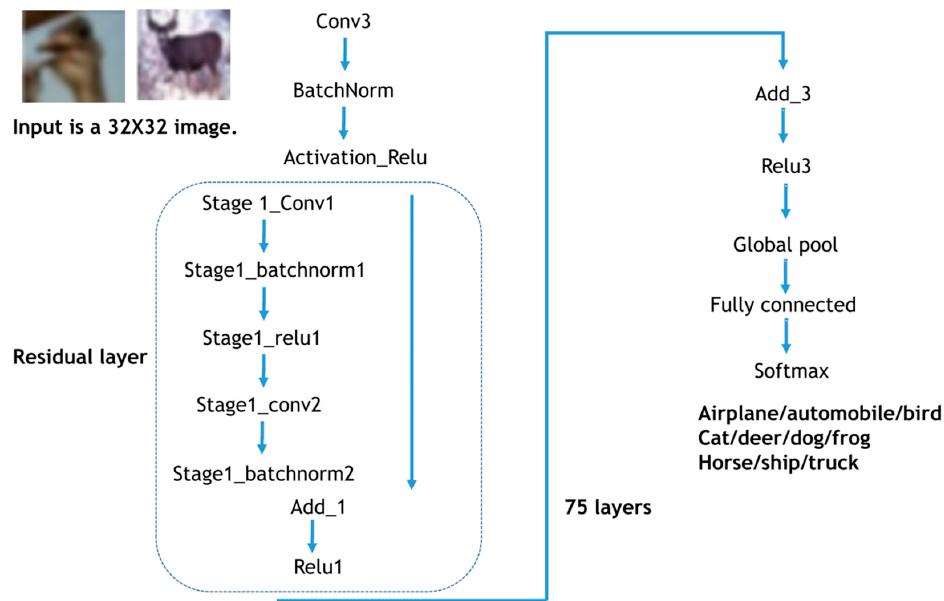
Figure 4. Residual convolution neural network architecture for image classification using the CIFAR dataset. The line (on the right side) in the residual layer represents a skipped connection.